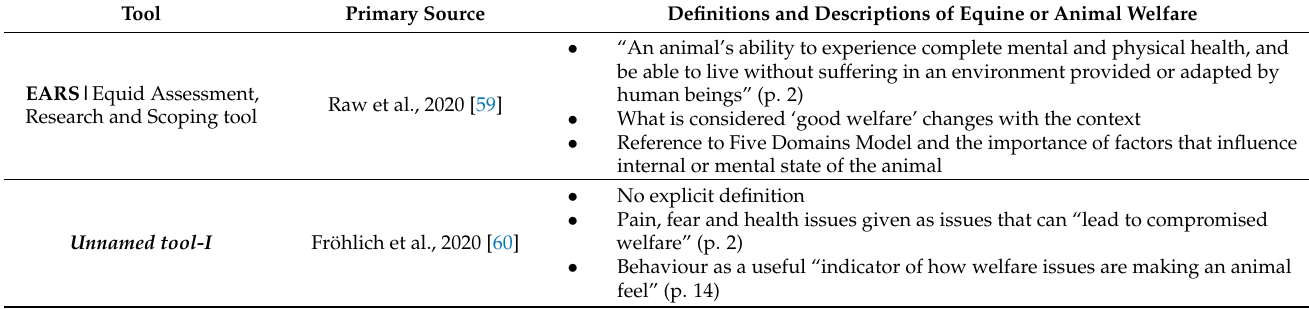
Table 2. Definitions and descriptions of equine or animal welfare in analysed publications of equine welfare assessment tools including their basis on other approaches such as the Welfare Quality ® principles of Good feeding, Good housing, Good health and Appropriate Behaviour, e.g., [57,66] and the Five Domains Model with its prioritisation of the animal’s mental state as their welfare state, e.g.,